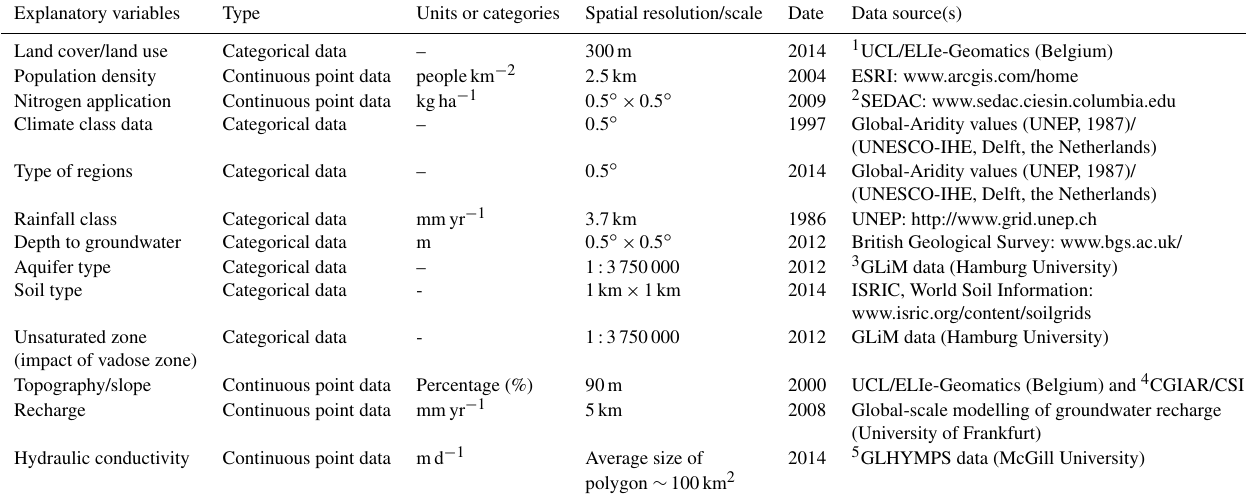
Table 3. Explanatory variables used in the MLR analysis.